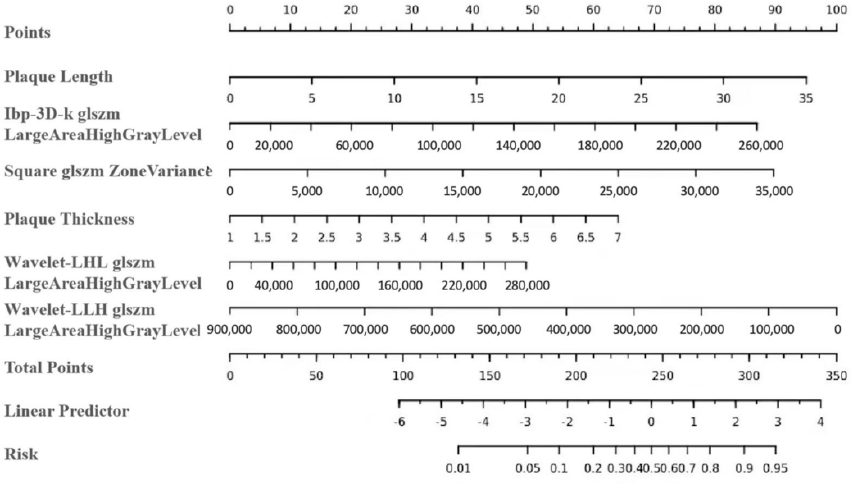
Figure 3. A radiomics-based nomogram incorporating plaque length, plaque thickness, and radiomics features for identifying carotid in-stent restenosis was developed in the training dataset. The probability score for stent restenosis is labelled on each axis, increasing from left to right. To use the nomogram, find the position of each variable on the corresponding axis, draw a vertical line on the point count axis to indicate the number of points, add up the number of points for all variables and draw a line on the total point count axis to determine the probability of in-stent restenosis on the lower line of the nomogram.